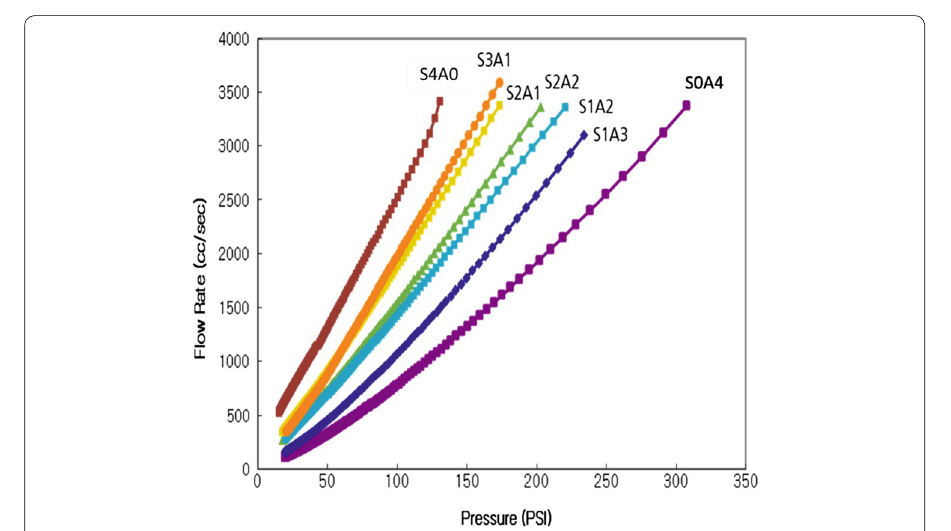
Fig. 6 Air permeability of PS/PA6 blend